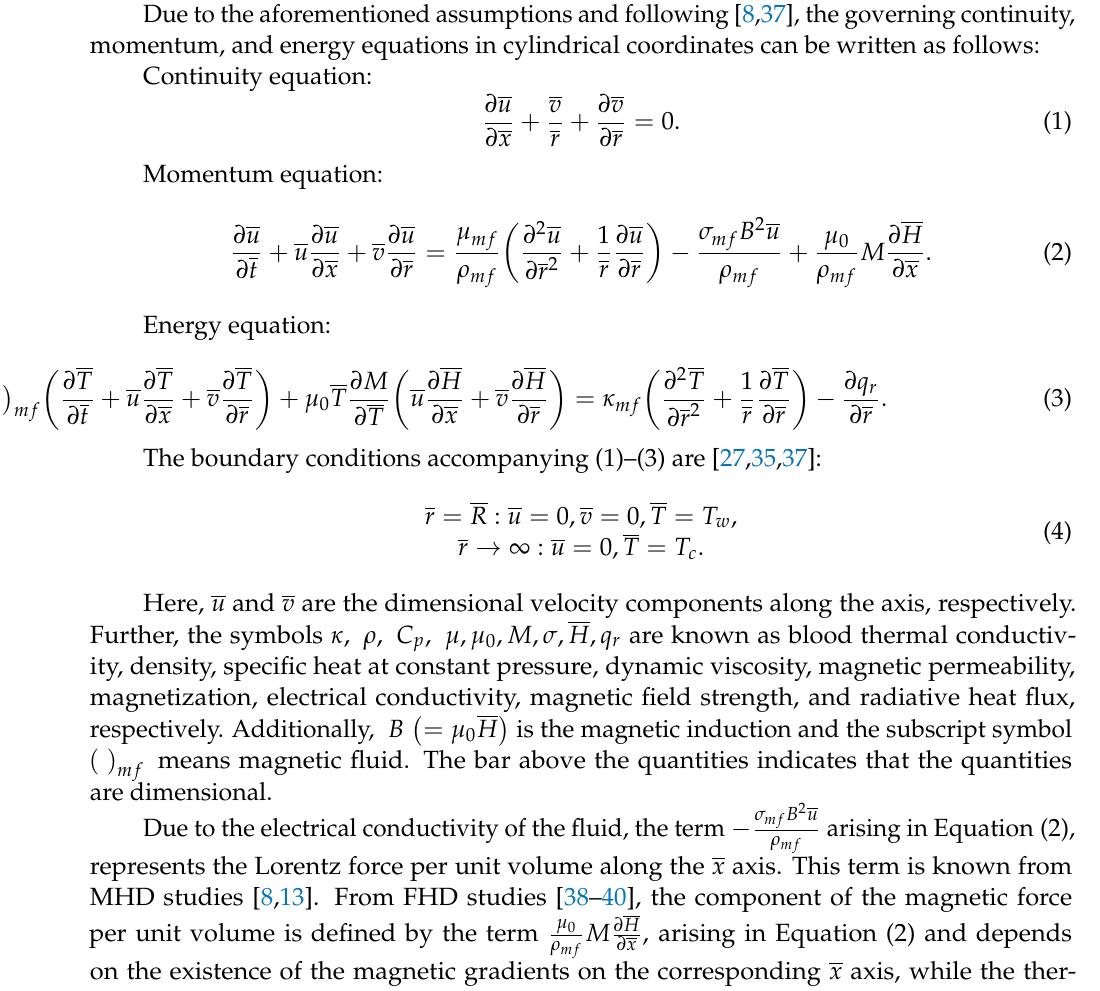
Figure 1. Schematic representation of geometry.